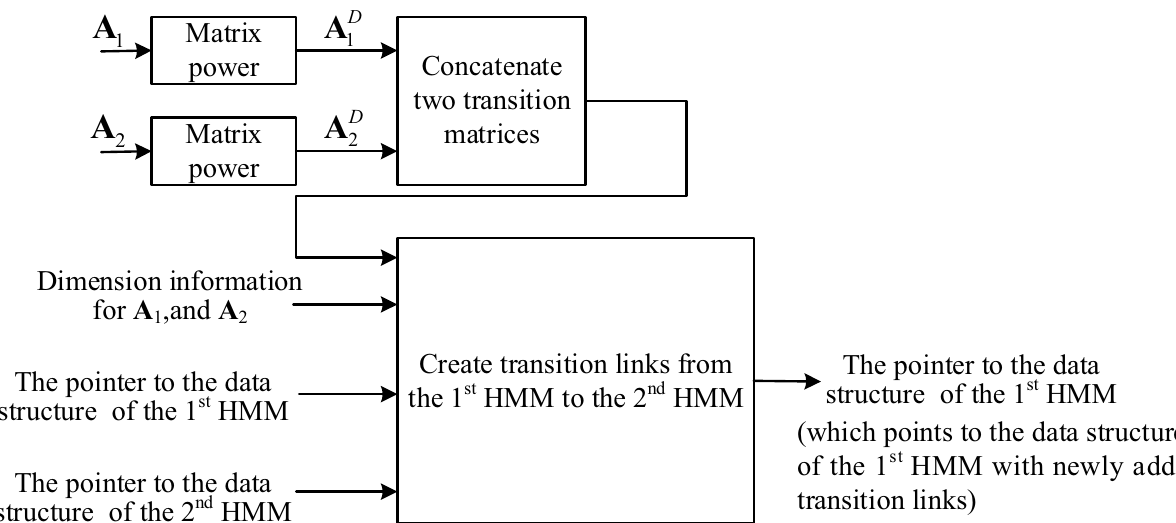
Fig 7. Creation of transition links from the 1 st HMM to the 2 nd HMM for frame-rate reduction factor D using the adapting-then-connecting approach.